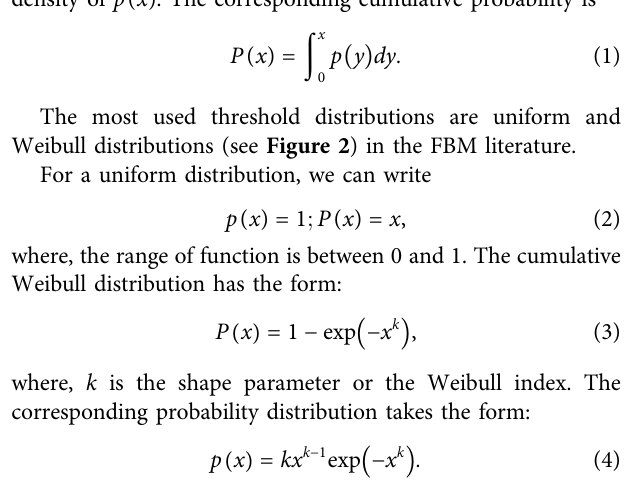
Frontiers in Physics |